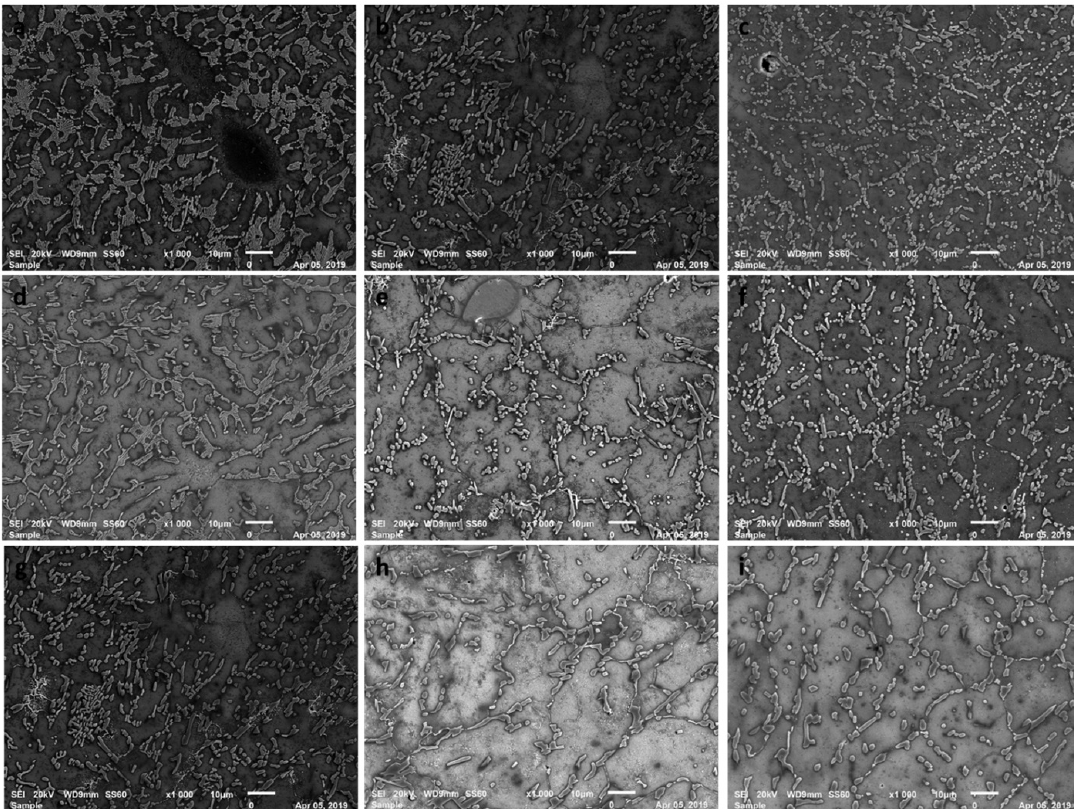
Figure 3. Scanning electron microscope images of Ti-Si-Fe-Cr-Nb alloy fabricated at 800W (a-c: top, middle and bottom layers), 1000W (d-f: top, middle and bottom layers) and 1200W (g-i: top, middle and bottom